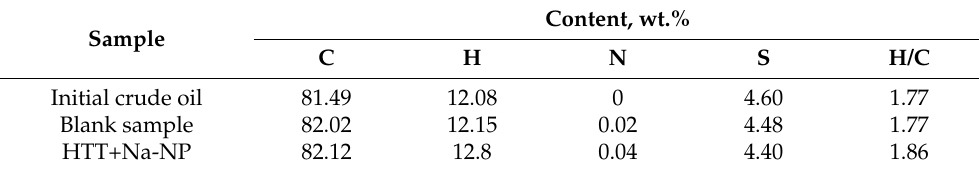
Table 2. Elemental analysis of the source oil and after aquathermolysis with and without a catalyst. Content, wt.% Sample C H H/C Initial crude